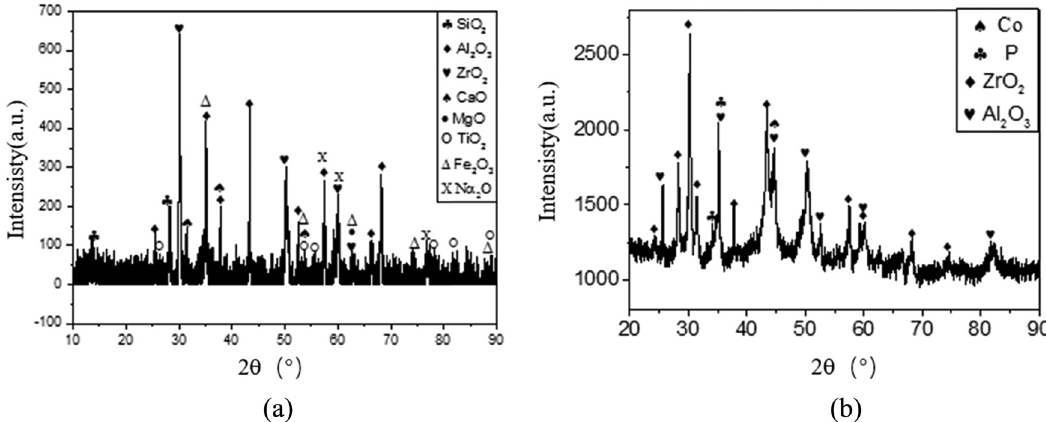
Figure 3: XRD analysis of unmodi fi ed ZTAp and modi fi ed ZTAp. ( a ) ZTAp with electroless cobalt plating on the surface, ( b ) the normal